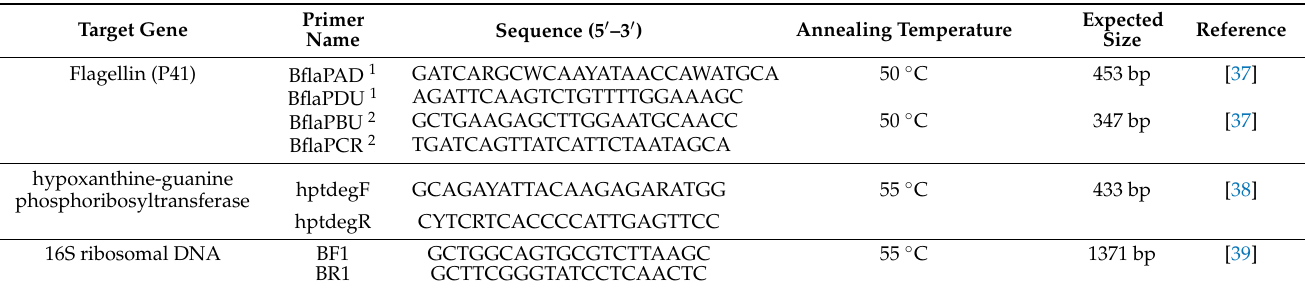
Table 1. Primers used in the conventional